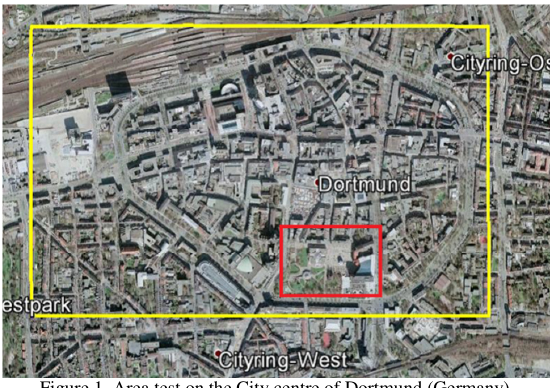
Figure 1. Area test on the City centre of Dortmund